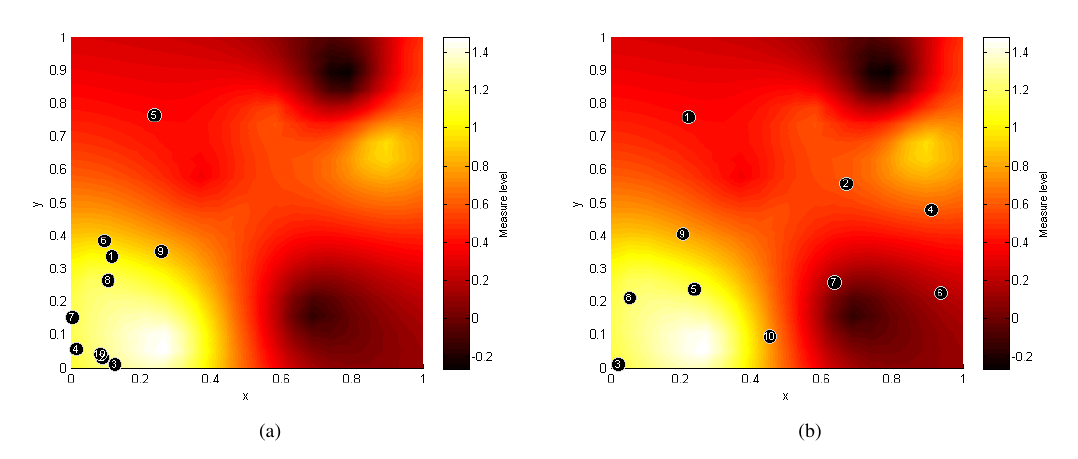
Fig. 8. The exploratory effect of parameter s on each agent. (a) For s = − 10 . Near agents exhibit preference for the same environment cue. (b) s = − 1 . The agents become more exploratory. 2Σ ∗ j